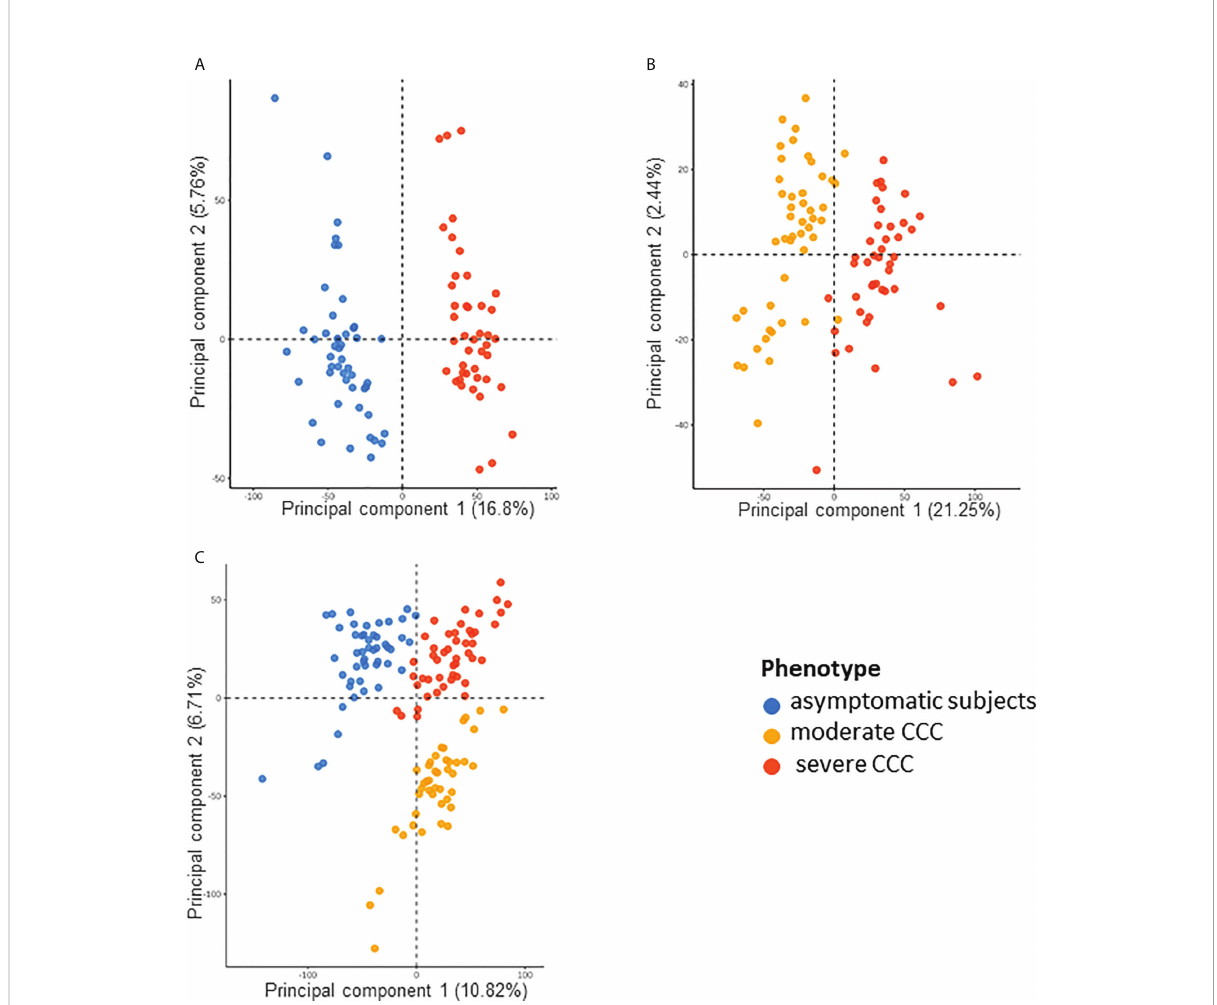
FIGURE 7 Analysis of samples distribution in the space of differentially methylated CpG sites for asymptomatic, moderate CCC and severe CCC samples. (A) Scatterplot of the two principal components of a PCA executed in the space of the 12624 CpG positions differentially methylated (DMP) between 48 asymptomatic blood samples and 90 CCC blood samples. (B) Scatterplot of the two principal components of a PCA executed in the space of the 6735 DMPs between 47 moderate CCC blood samples and 43 severe CCC blood samples. (C) Scatterplot of the two principal components of a PCA executed in the space of the 18889 CpG positions (union of the two previous sets) for the three groups of